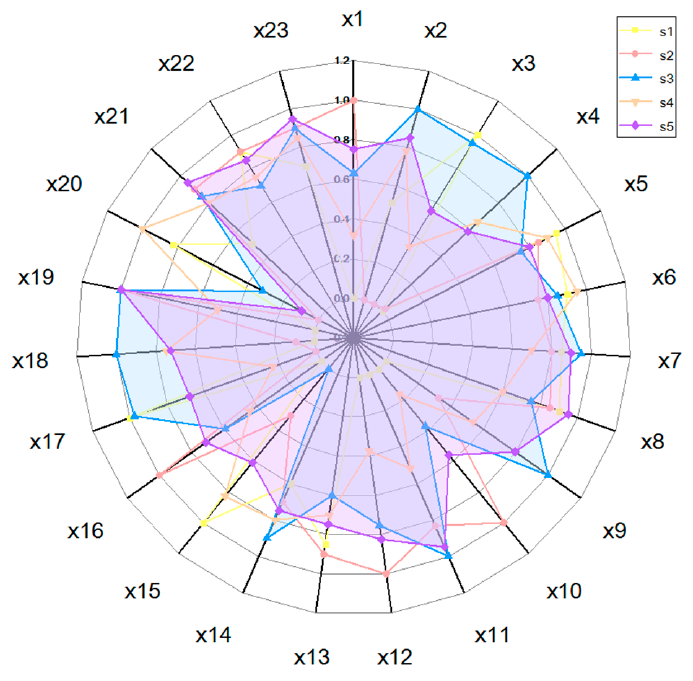
Figure 4. The normalization value of 5